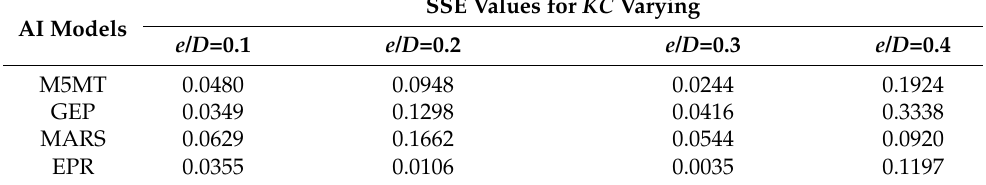
at various e / D ratios and R